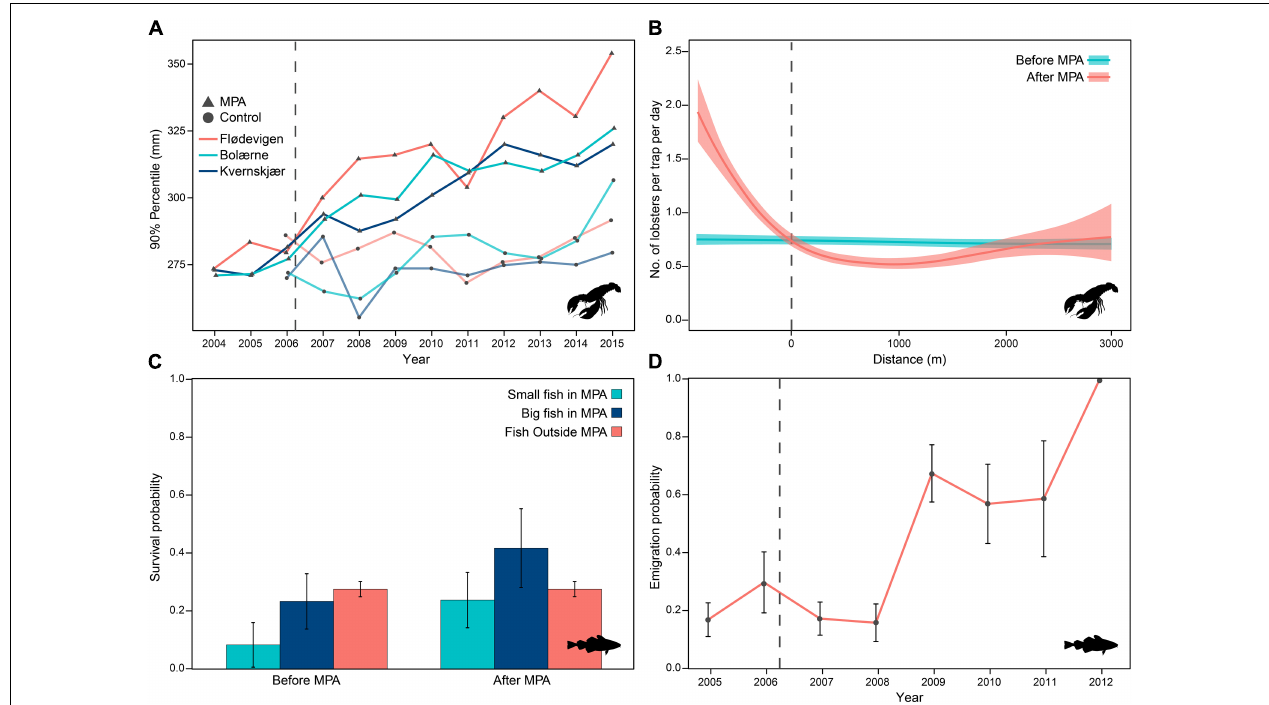
FIGURE 2 | Population effects of MPAs before and after MPA implementation: (A) size-structure indicator (90 percentile) of H. gammarus in three MPAs (triangles) and three control areas (circles) in Skagerrak (modified from Fernández-Chacón et al., 2020); (B) cross-border abundance gradient in H. gammarus (modified from Nillos Kleiven et al., 2019); (C) average survival rates of G. morhua in a MPA and multiple control areas; and (D) development in emigration probability of G. morhua tagged inside a MPA (modified from Fernández-Chacón et al.,